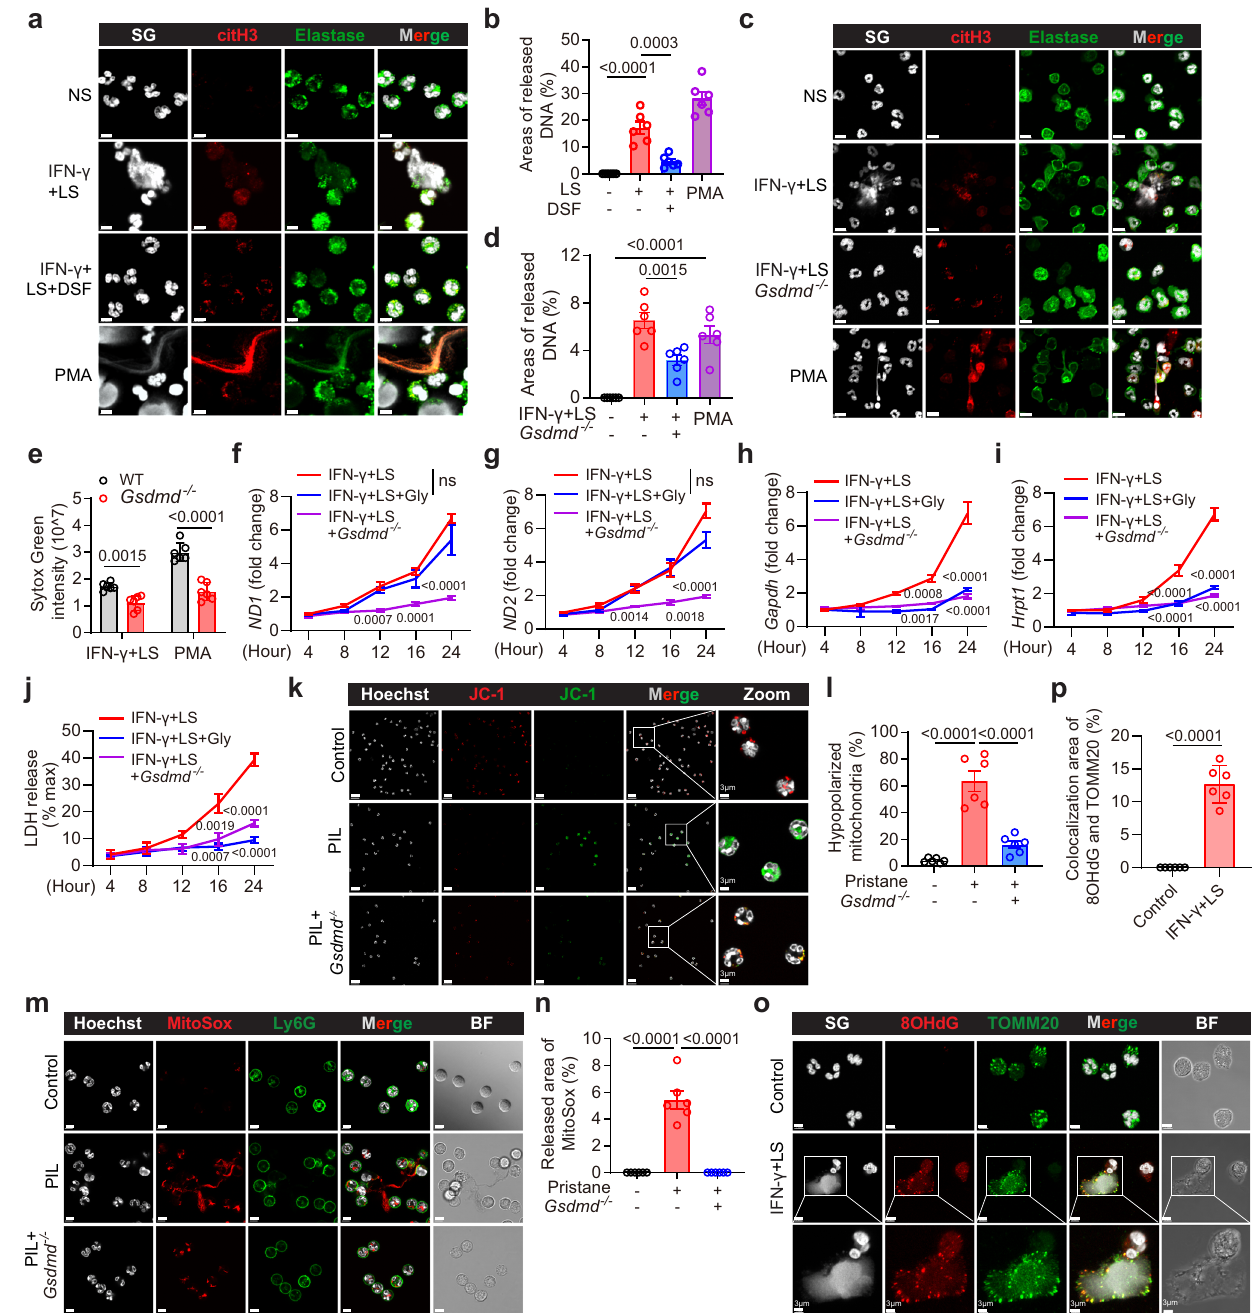
Fig. 3 | GSDMD is required for the release of NET-associated DNA and mtDNA following lupus serum treatment. a Immuno fl uorescence staining of citH3, elastase,andSytoxGreen(SG).Cellsweretreatedwithnormalserum(NS)fromHV, LS from SLE patients plus IFN- γ , pretreated with DSF, or PMA. Scale bar, 5 µ m. b Quantitative analysis of areas of released DNA in ( a ). Symbols represent the percentage of extracellular DNA area as compared to the entire FOV. Two healthy donors were used in one experiment, plots were pooled from three independent experiments using cells from 6 healthy donors. c Immuno fl uorescence staining of SG, citH3 and Ly6G. scale bar, 15 µ m. d Quantitative analysis of areas of released DNA in ( c ). Symbols represent the area percentage of extracellular DNA relative to the entire FOV. e Quantitative analysis of SG intensity in the supernatant collected from WT and Gsdmd − / − BM neutrophils following stimulation with LS plus IFN- γ or PMA. qPCR analysis of mitochondrial-encoded gene ND1 ( f ) and ND2 ( g ), nuclear- encoded gene, Gapdh ( h ) and Hrpt1 ( i ) in the supernatant. n =3